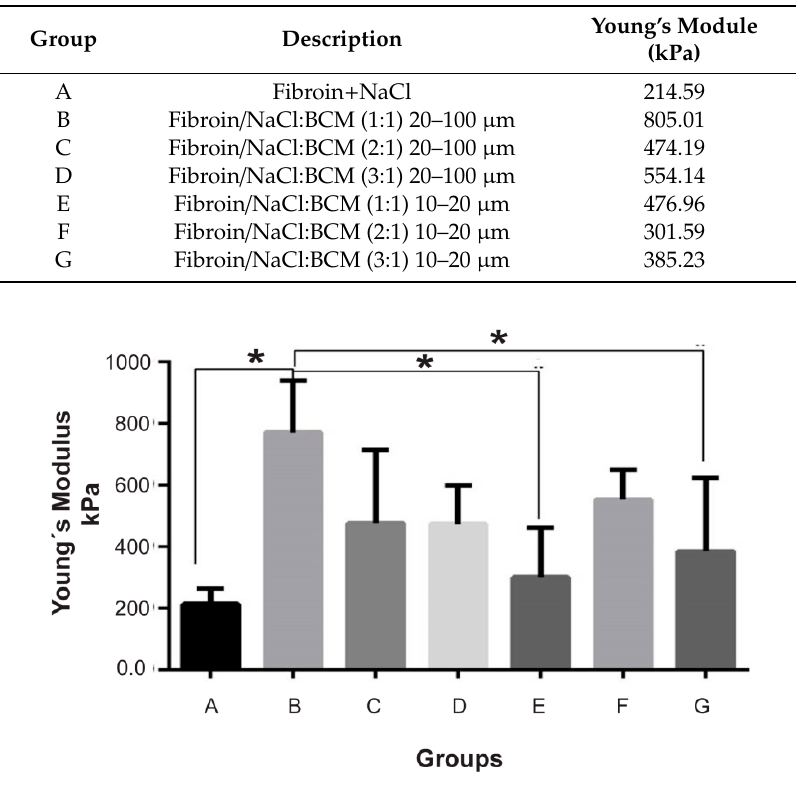
Figure 2. The e ff ect of BCM particle size on the mechanical properties of silk fibroin sca ff olding. The determination of the Young’s modulus of fibroin and NaCl (as porogen) hydrogels, and biofunctionalized with the BCM of two di ff erent particle sizes; the tested proportions were 1:1, 2:1 and 3:1. The error bars represent the standard deviation; * p ≤ 0.05 based on the ANOVA analysis.